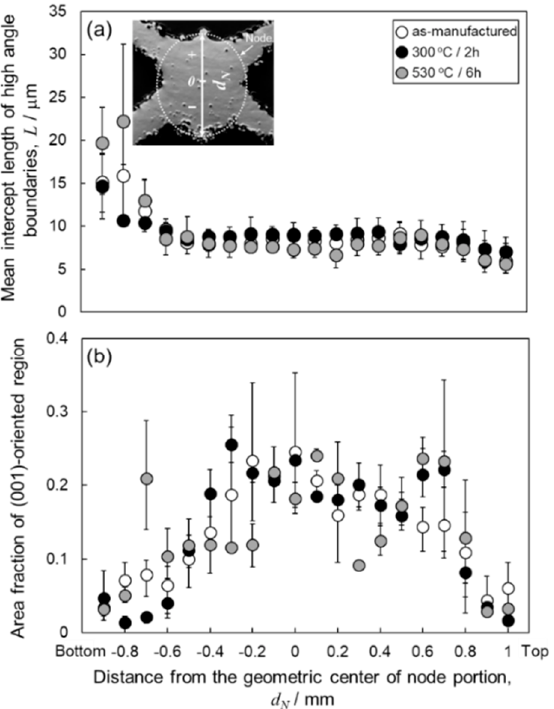
Figure 8. Change in ( a ) mean intercept length of high-angle boundaries and ( b ) area fraction of the (001)-oriented region plotted with vertical distance from the geometric center ( d N ) of the node portion of the lattice specimen with heat treatment.